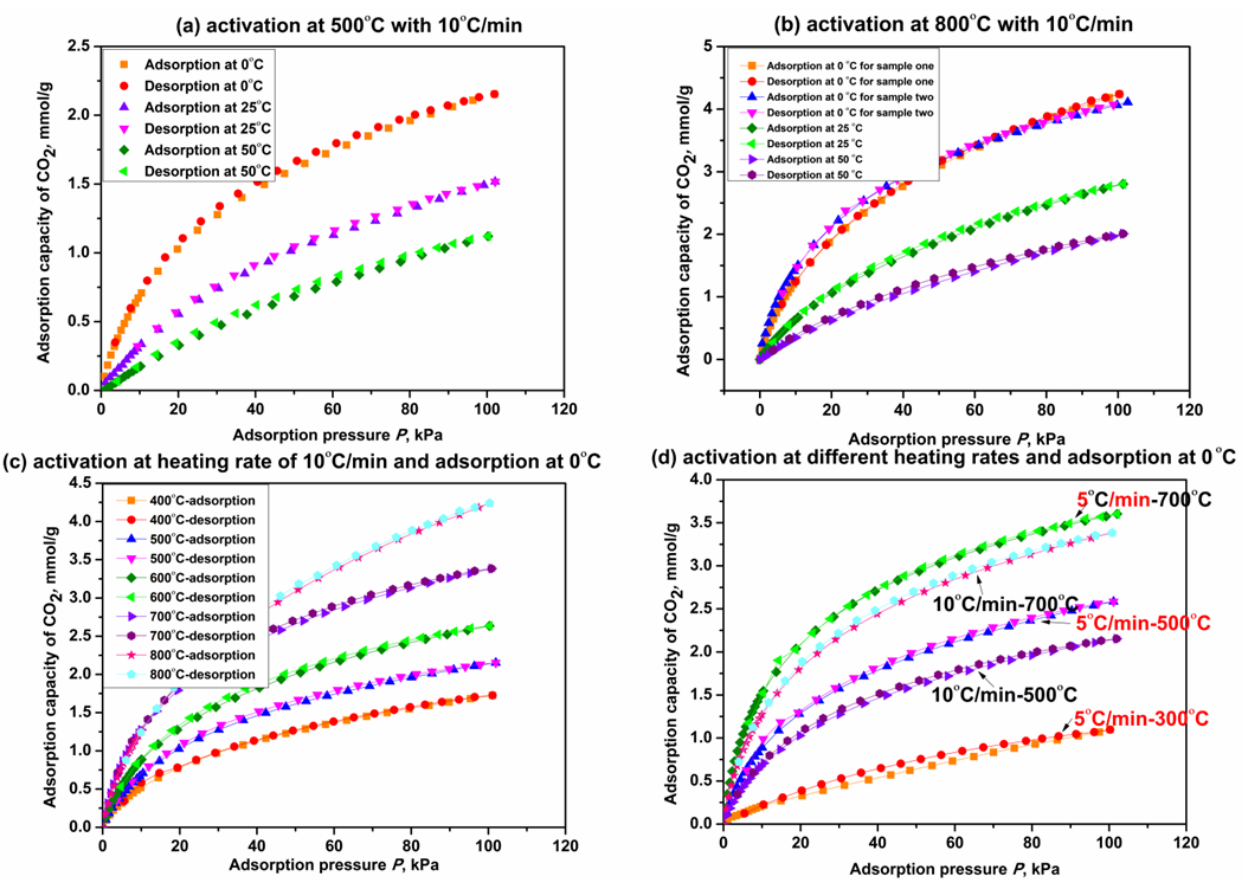
Figure 7. CO 2 adsorption on β -CD derivatives at different adsorption temperatures ( a , b ); final activation temperatures ( c ) and heating rates ( d ).